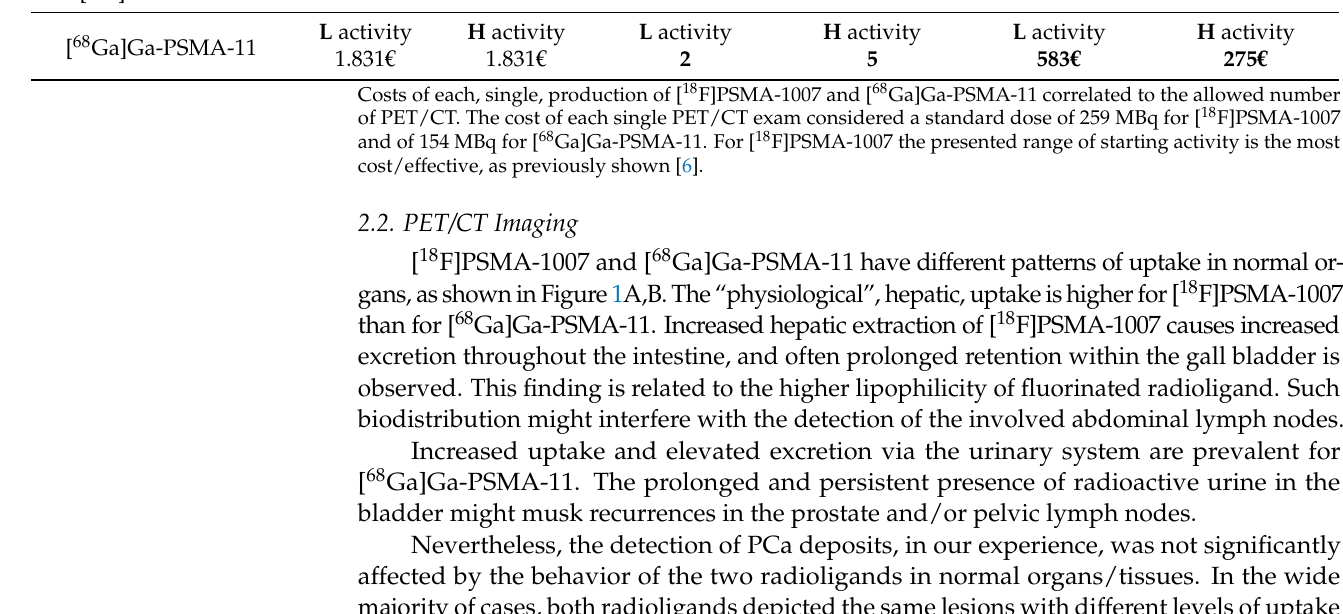
Table 2. Costs of production and PET/CT exams for [ 18 F]PSMA-1007 and [ 68 Ga]Ga-PSMA-11. Radioligand Costs of Production N ◦ PET/CT Performed Costs for Single PET/CT Exam 5.454